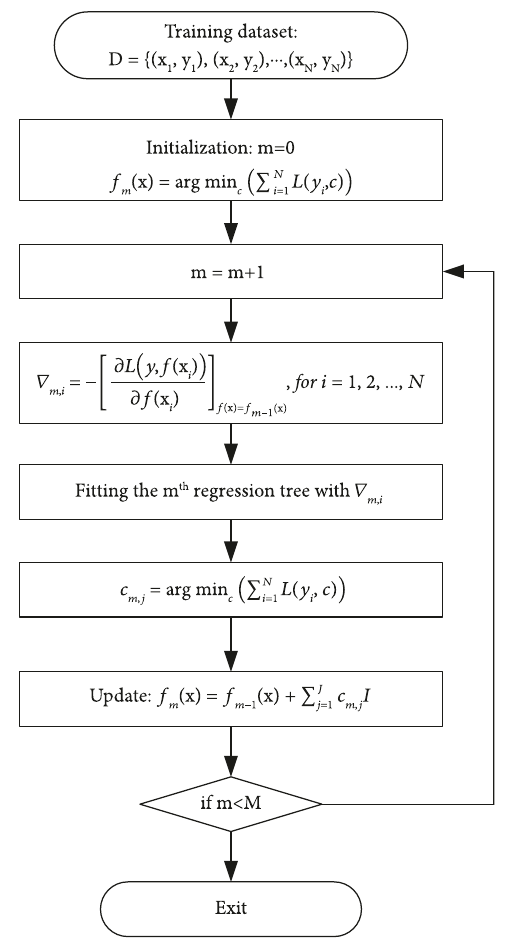
Figure 3: Solution process of GBRT